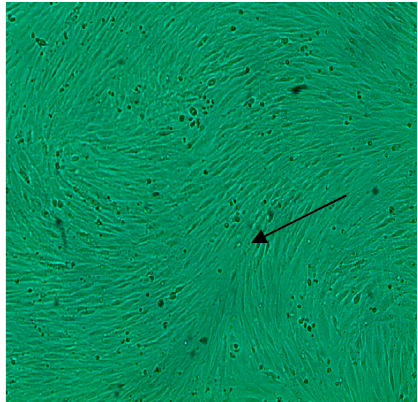
Figure 2. Representative myotubes derived from passage number 7; myotubes taken at (Ham-F10, 1 % P/S) after 7 days starvation (10×).